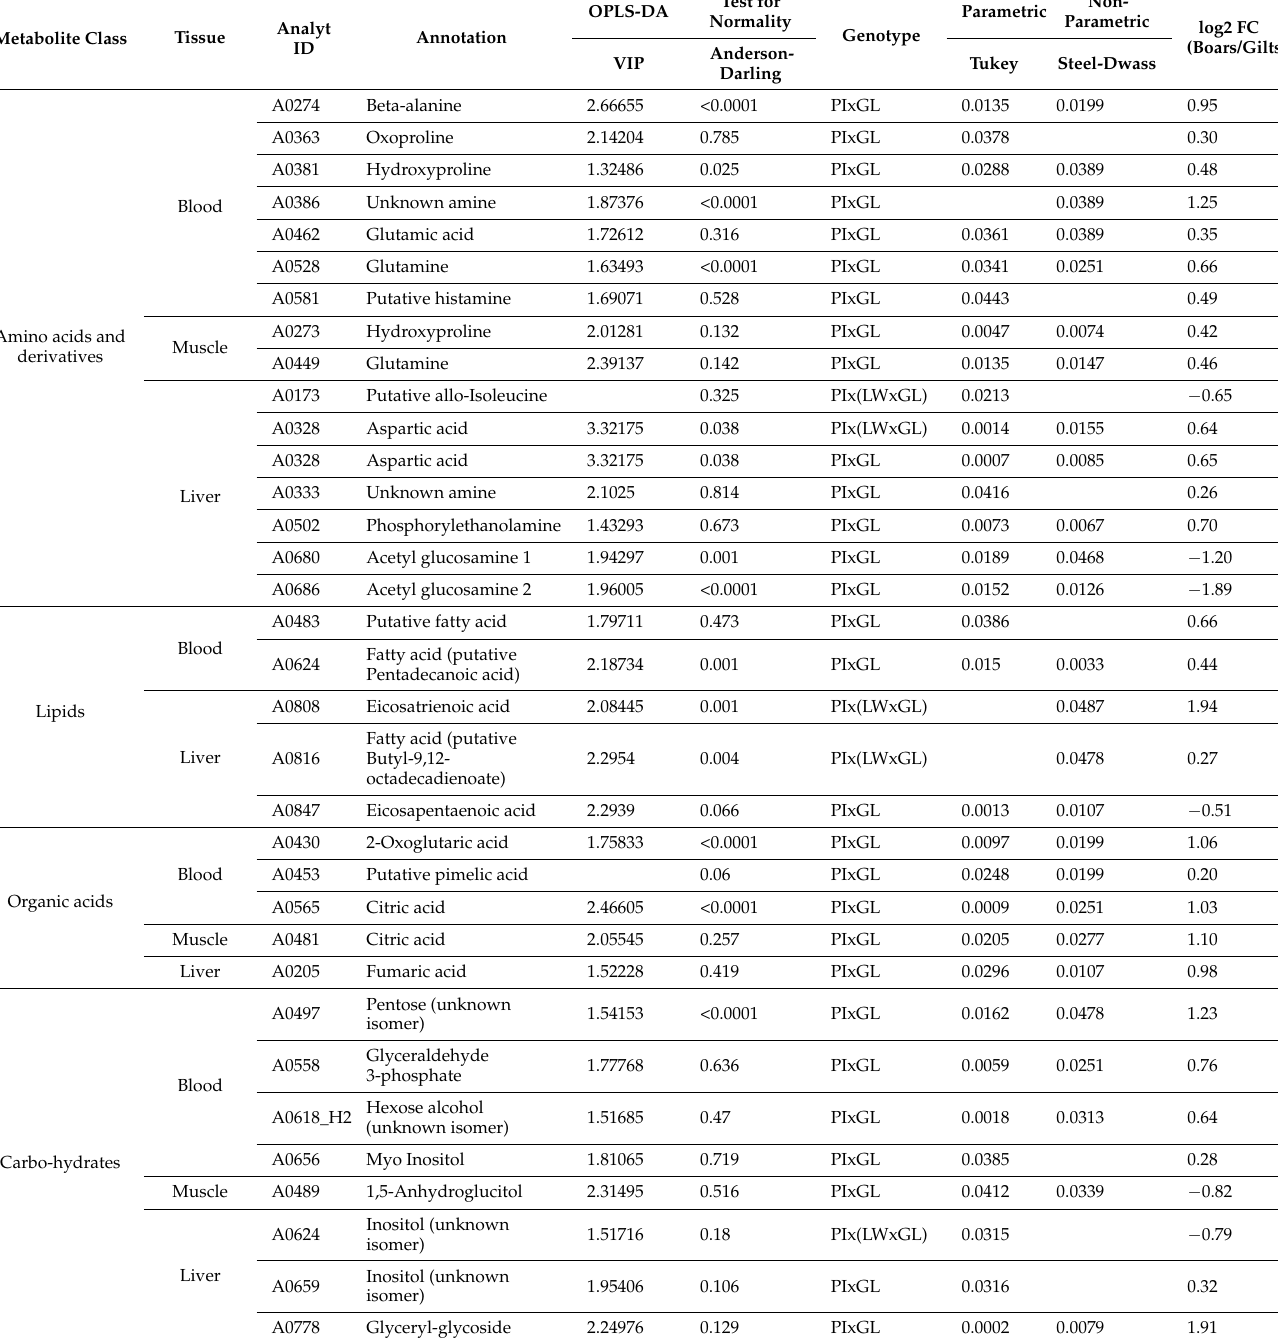
Table 2. Significant differences between gilts and boars regarding dependence on the genotype. According to the outcomes from Anderson-Darling’s Test for normal distribution the results from Tukey HSD Test or Steel-Dwass Test have to be considered. A data table with candidate features from T-Test/Wilcoxon Test and OPLS-DA (VIP scores) analysis is provided in Supplementary Table S2; n.a.—not applied due to limit of detection; FC—fold